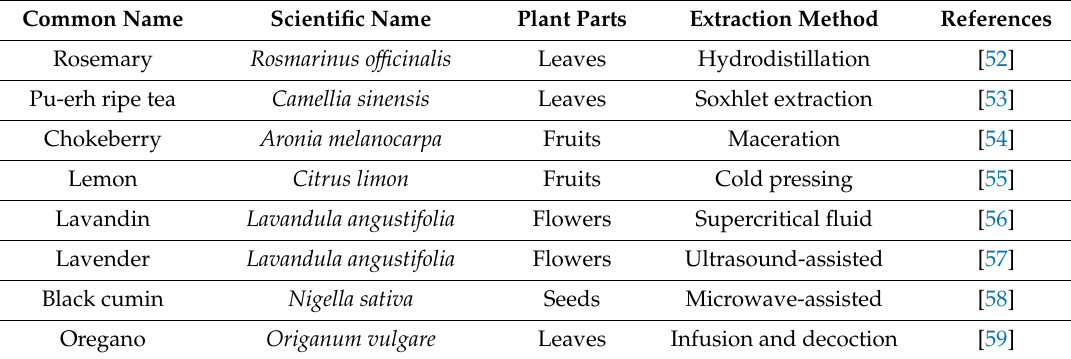
Table 1. Various extraction methods for di ff erent essential